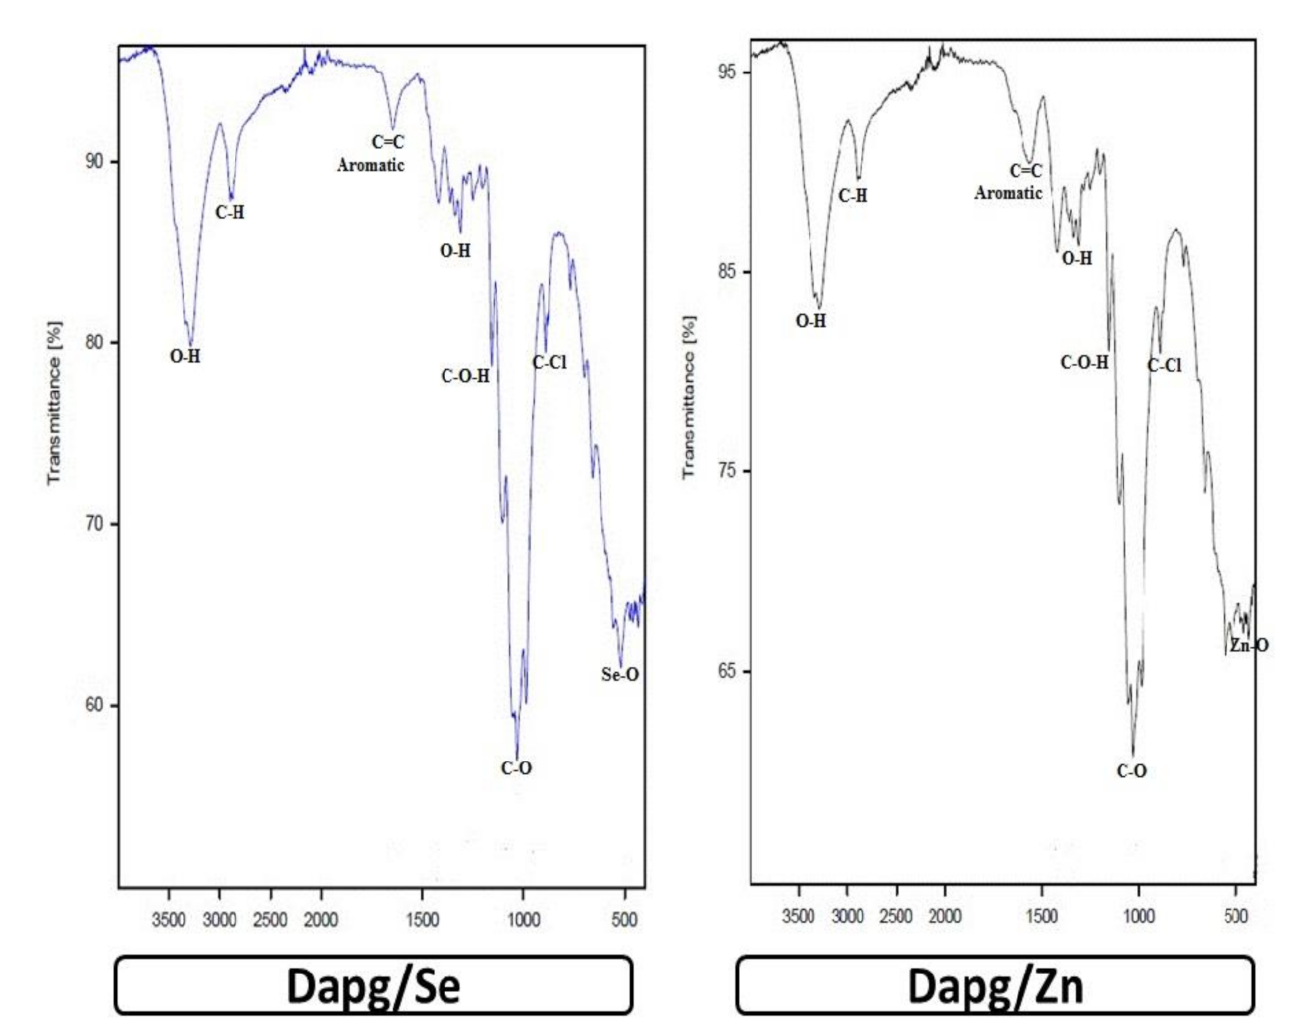
Figure 3. FT-IR of Dapg, Cr–Dapg, Zn–Dapg and